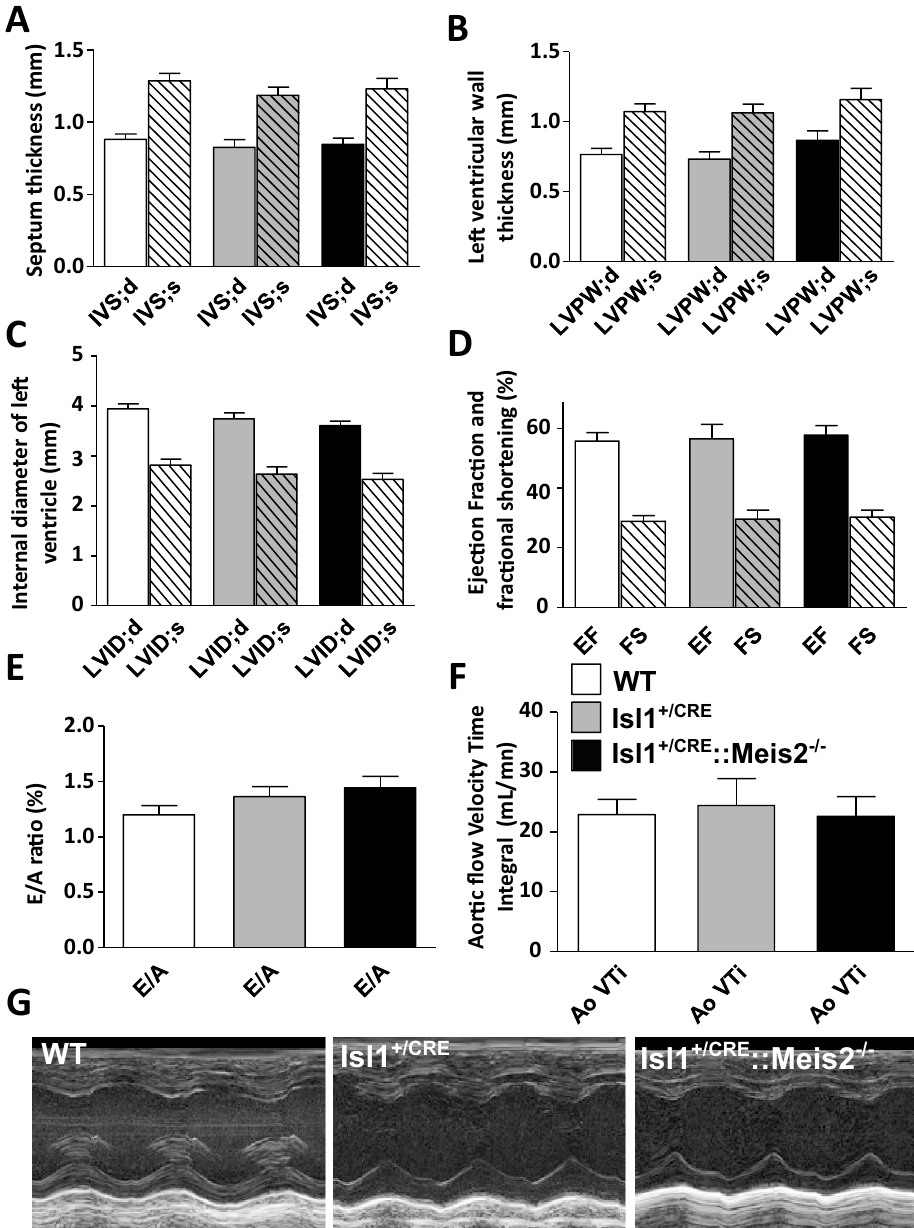
Figure 1. Isl1 +/CRE ::Meis2 LoxP/LoxP mice are devoid of morphological and contractile heart defects. Morphologic and left ventricular function parameters assessed by Doppler echocardiography in WT, Isl1 +/CRE and Isl1 +/CRE ::Meis2 LoxP/LoxP mice. Measures of IVS ( A ), LVPW ( B ), LVID ( C ), EF and FS ( D ) showed no difference between WT, Isl1 +/CRE and Isl1 +/CRE ::Meis2 LoxP/LoxP mice. Peak early ( E ) and late atrial contraction ( A ) mitral inflow wave velocities were measured and the E/A ratio was calculated ( E ) as the ascending aortic blood flow ( F ). ( G ) Representative M-modes images of Doppler echocardiography in WT, Isl1 +/CRE and Isl1 +/CRE ::Meis2 LoxP/ LoxP mice. Abbreviations: IVS = thickness of the interventricular septum during diastole (d) and systole (s); LVPW = thickness of the posterior wall of the left ventricle during diastole (d) and systole (s); LVID = left ventricular internal diameter during diastole (d) and systole (s); EF (%) = Ejection Fraction in M-mode; FS (%) = Fractional Shortening in M-mode. Pulsed-wave Doppler of the ascending aortic blood flow was recorded permitting measurements of the velocity time integral (AoVTI). n = 9–11 mice in each